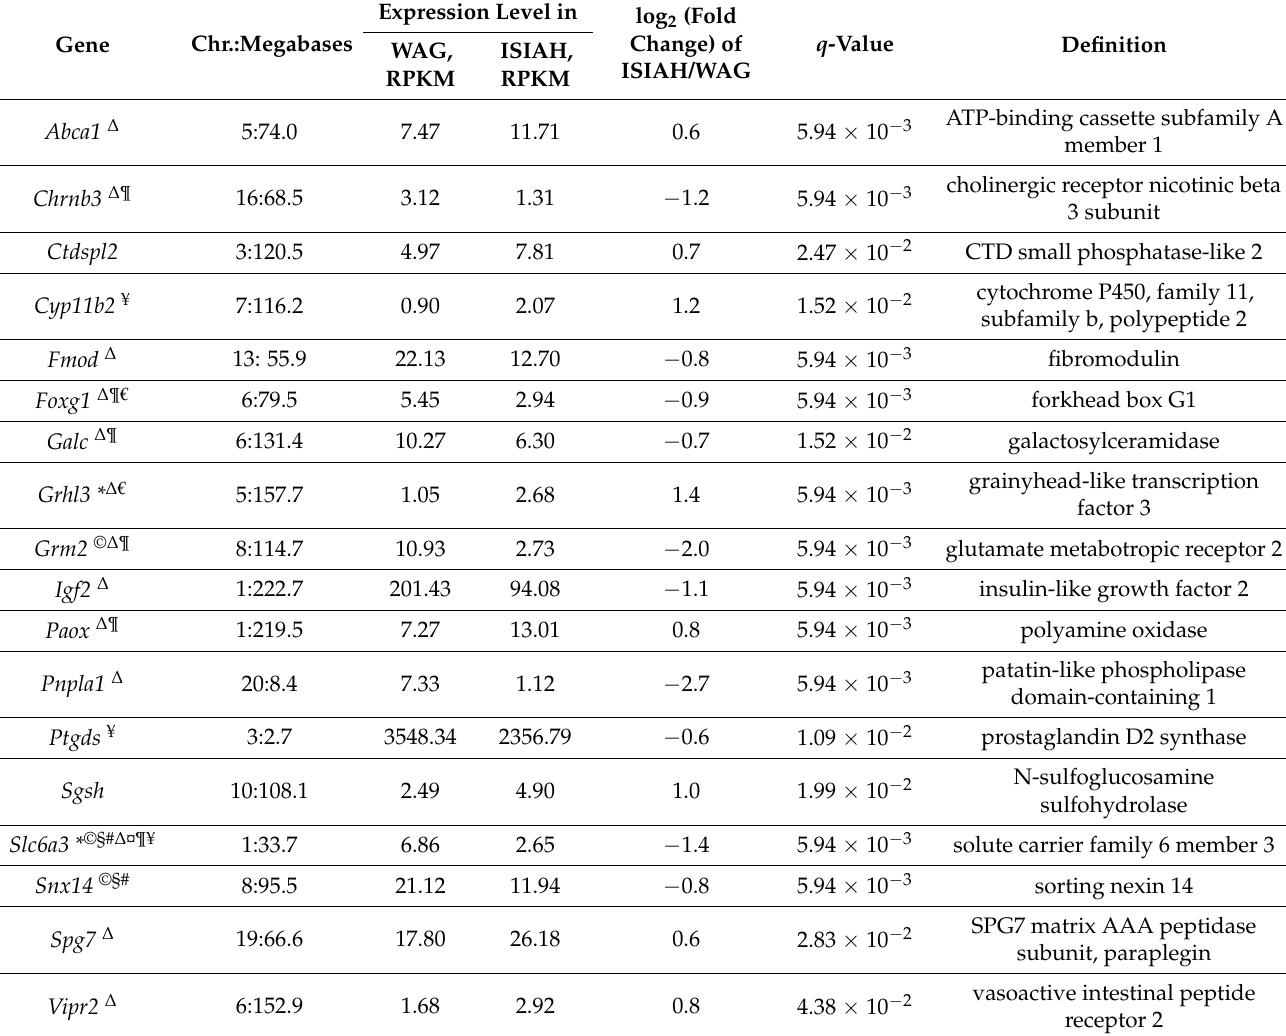
Table 2. Hypothalamic DEGs associated with the behavior/neurological